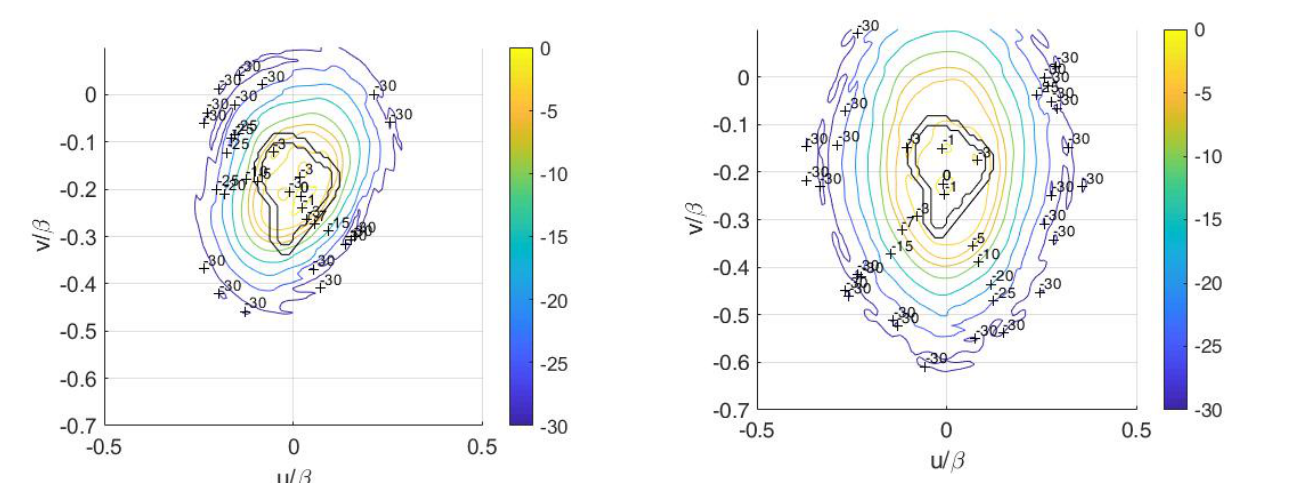
FIGURE 6. Directivity pattern synthesized by a local optimizer using a phase representation based on Zernike polynomials and skipping